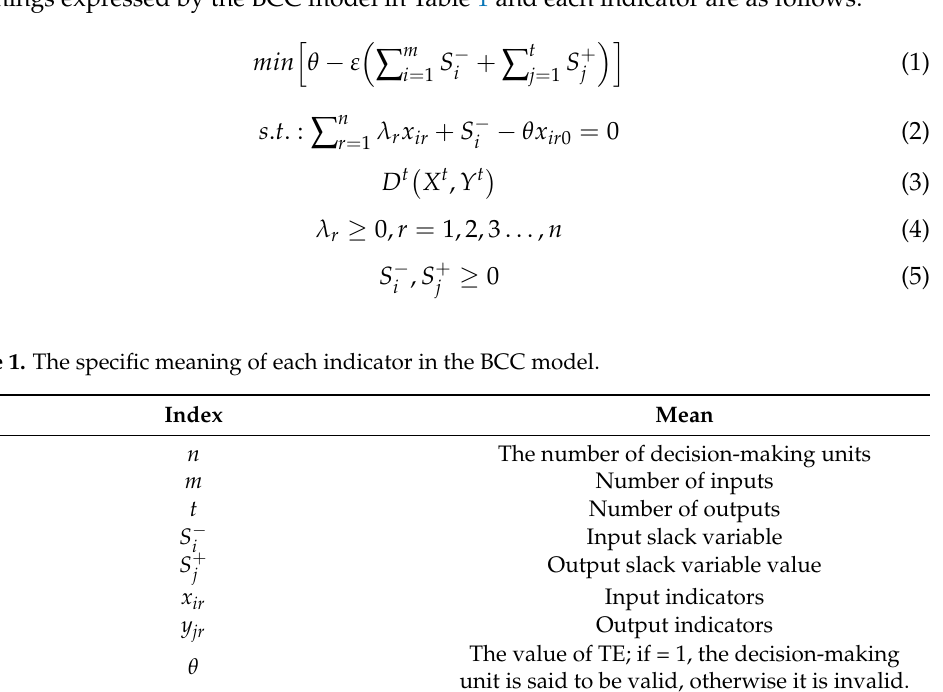
Input slack variable Output slack variable value